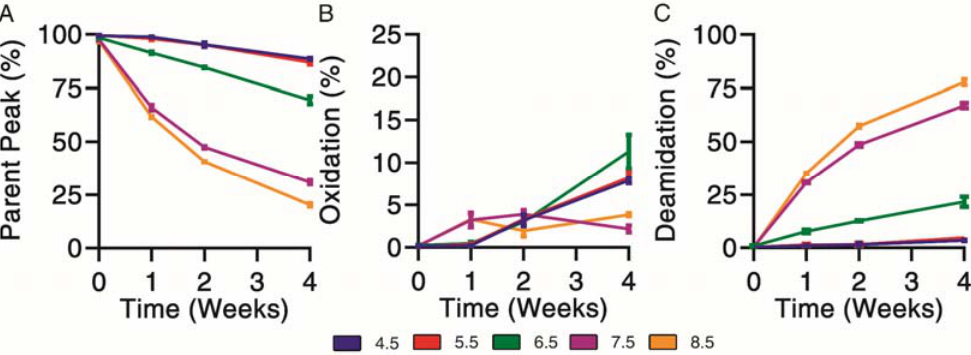
Figure 2. Kinetics of chemical degradation determined by reverse-phase liquid chromatography separating ( A ) parent peak from ( B ) oxidation and ( C ) deamidation chemical impurities during incubation of exenatide solutions pH 4.5–8.5 at 37 °C for 4 weeks. ( n = 3, mean ± SEM).